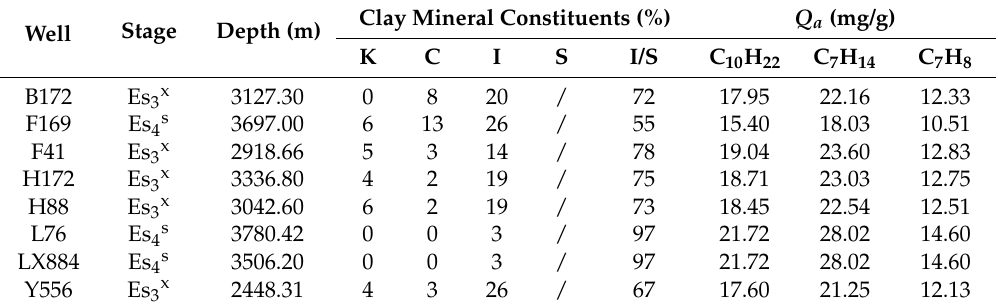
Table 4. Clay mineral constituents and total adsorbed hydrocarbon per gram of clay minerals in shale samples. Well Stage Depth